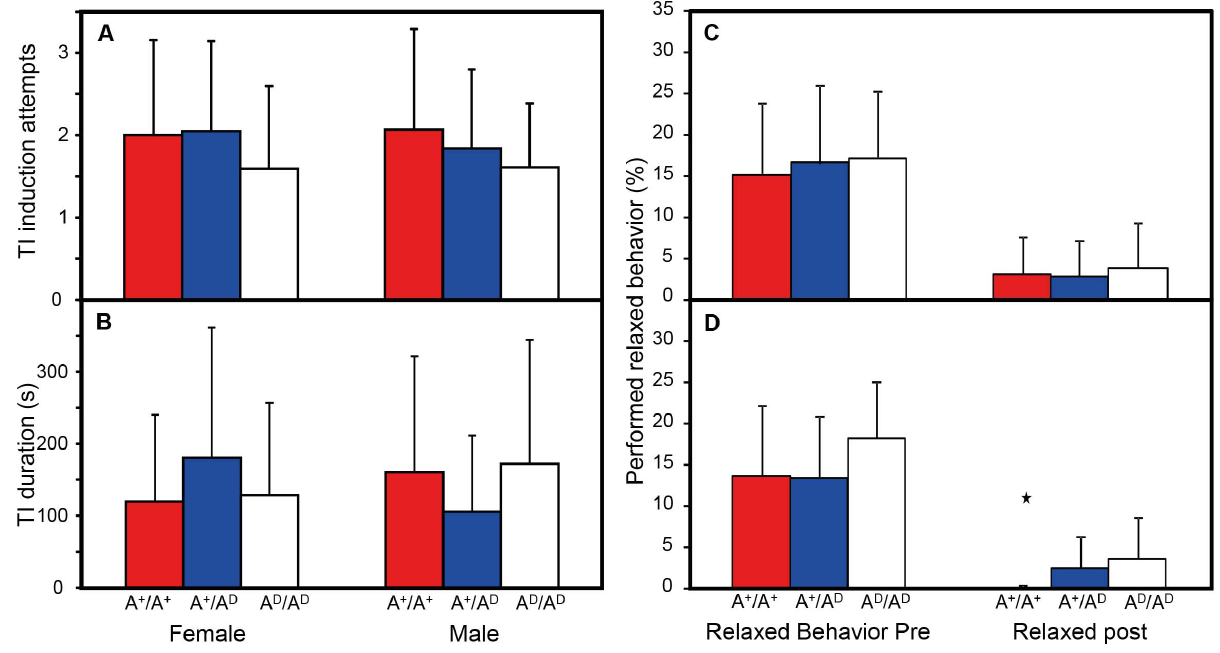
Figure 4. Behavioural variables from Tonic Immobility (TI) and Aerial Predator tests. A) TI induction attempts and B) TI duration (s). C) and D) Relaxed behavior pre and post exposure to the aerial predator in males (C) and in females (D). Data shown as mean and standard deviation. Star indicates a significant difference between genotypes (p , 0.05).